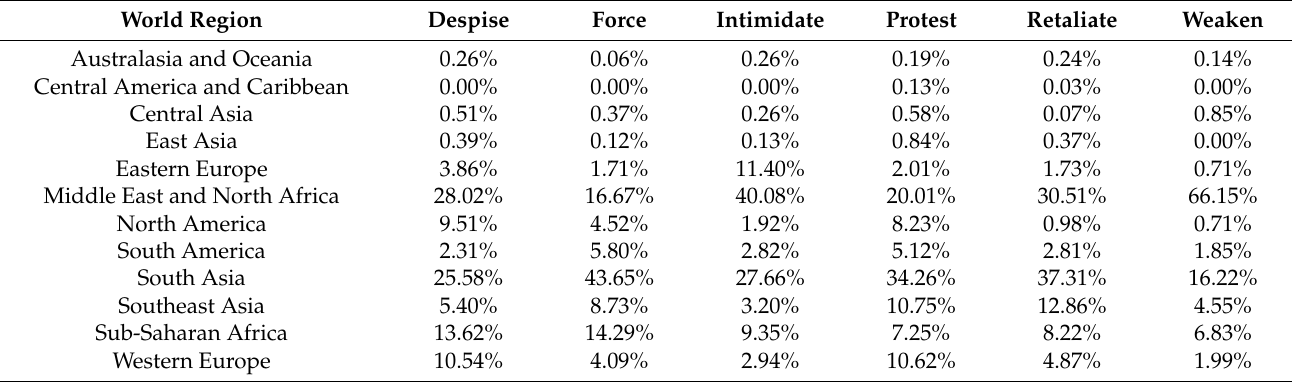
Table 3. Proportion of each PAC by region of the world.